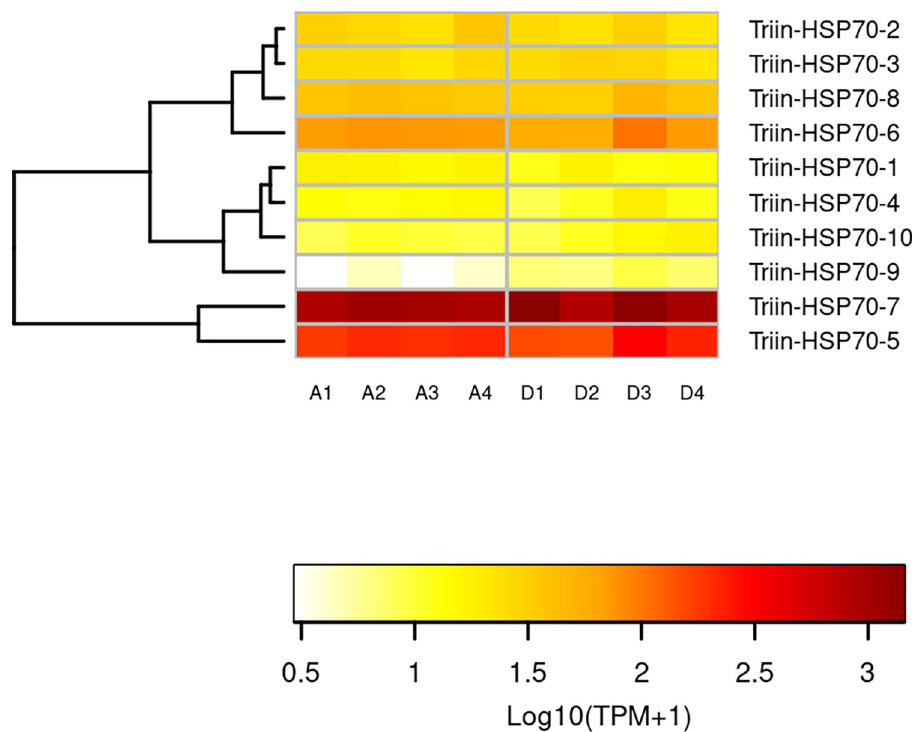
Fig 5. Effect of deltamethrin on the transcription of the T . infestans HSP70 family. The heatmap was created using Transcript per Million (TPM) as input of the gplot R package. Transcript abundance was represented as Log 10 (TPM +1) where white/red represents the lowest/highest expression. A dendrogram was plotted using a hierarchical clustering of gene expression values based on Euclidean distance and complete linkage method for clustering. A: acetone (control) samples. D: deltamethrin-treated